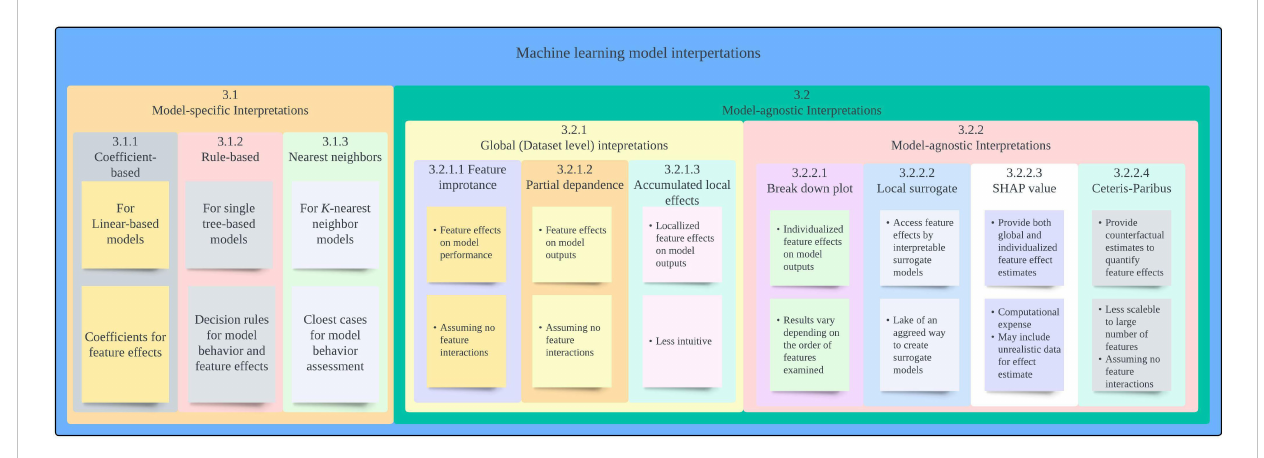
FIGURE 1 Summary of interpretation approaches covered. SHAP: Shapley additive